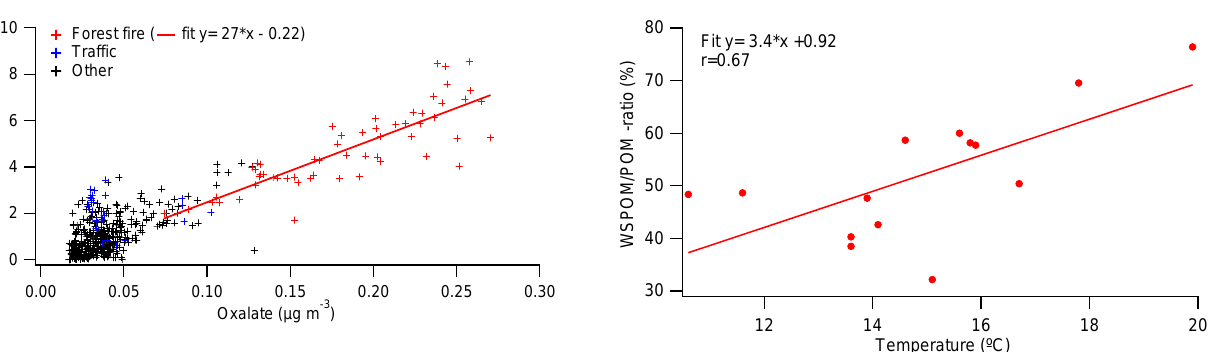
Fig. 5. The concentration of water-soluble particulate organic mat- ter versus concentration of oxalate for different sources of WSPOM. The equation ( y = kx + b ) of fitted curve for samples collected dur- ing the forest fire episode is represented after the legend. For the other periods the concentrations are below quantification limit and the results are plotted to figure only for qualitative purposes.